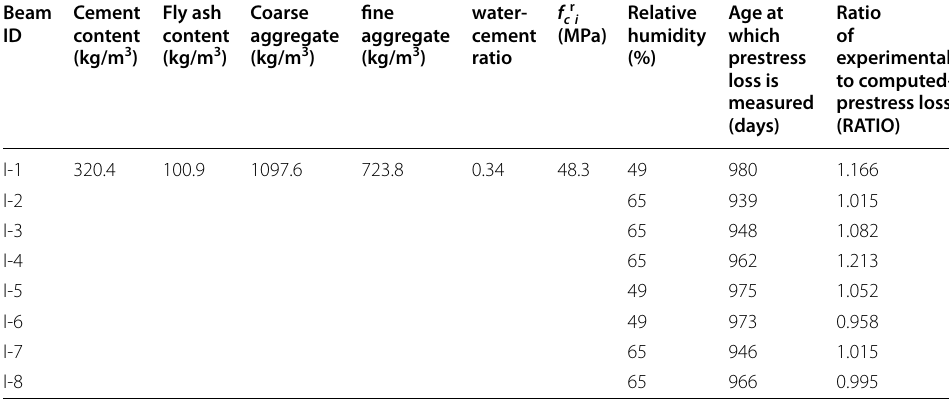
Table 2 Details of the PSC bridge girders considered (Garber et al. (Garber et al.